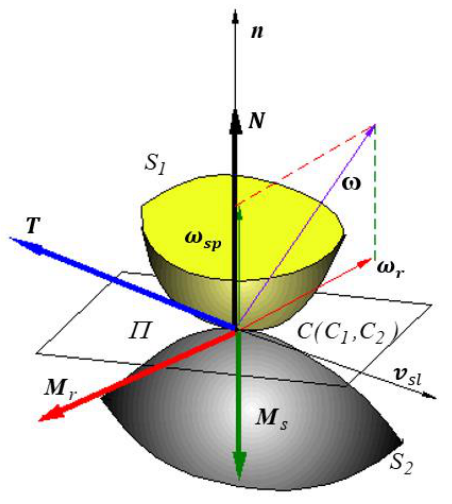
Figure 1. The components of friction torsor in a Hertzian point